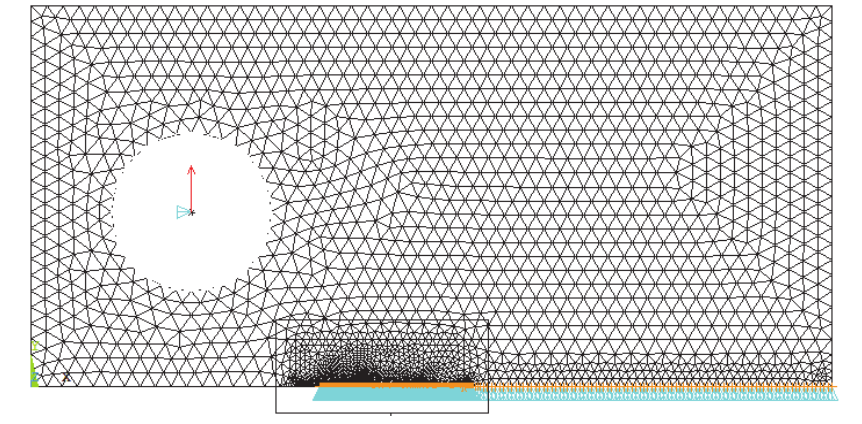
Figure 2. Finite element mesh of the CT specimen